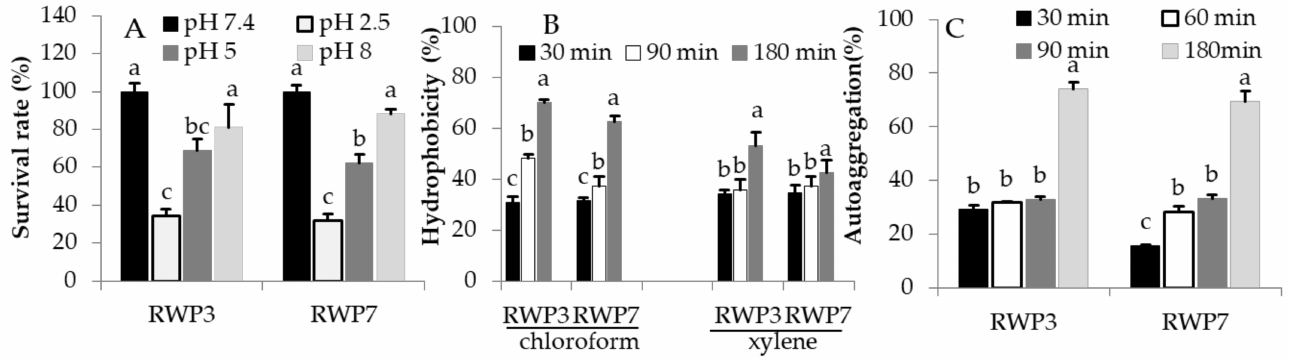
Figure 1. Probiotic characteristics of isolated strains RWP-3 and RWP-7. ( A ) Survival of isolates in GIT conditions, ( B ) Hydrophobicity, ( C ) Auto-aggregation property of isolates. Data were represented as mean ± SEM of three replicates. a,b,c p < 0.05 alphabets between bars represent significance between the